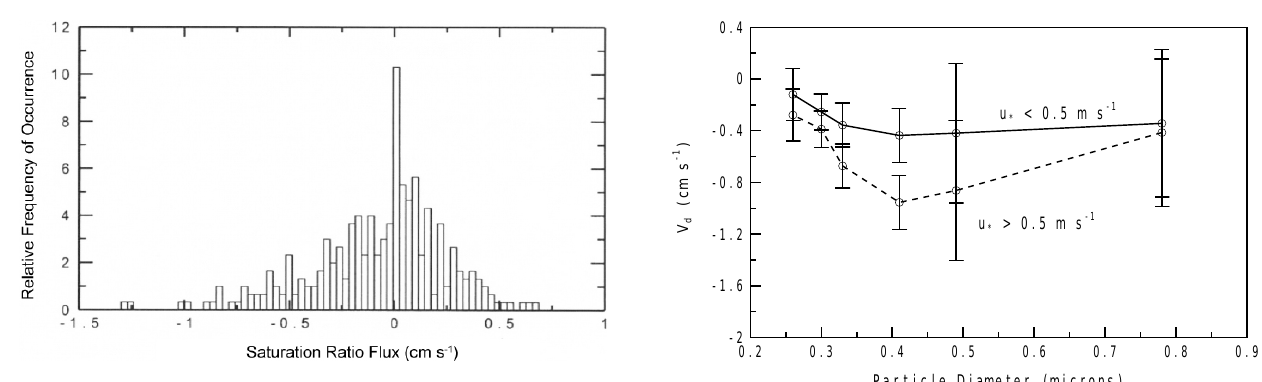
Fig. 5. Frequency of occurrence for saturation ratio fluxes (w 0 S 0 ) during BEARPEX’07 measurements. The positive values were ob- served at night or early morning while negative values were ob- served during the middle of the day. Negative values of w 0 S 0 are downward.